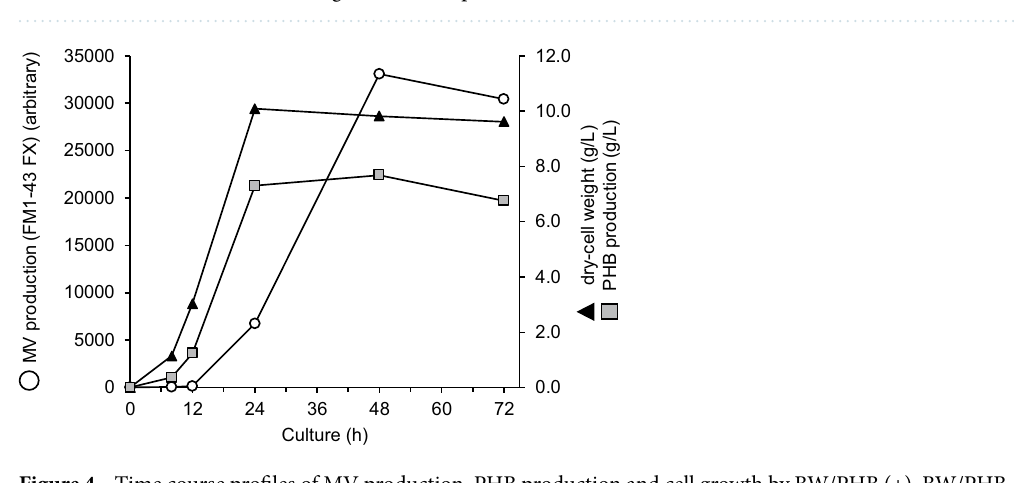
Figure 3. Microscopic and biochemical characterization of the MVs. ( A ) TEM images of MV fractions of BW/ PHB (+). Scale bar represents 100 nm. ( B ) The particle size distribution was analyzed by NanoSight tracking analysis. ( C ) Protein profiles of MV preparations from BW/PHB (+), BW/PHB (−) and BW. Purified MV samples were analyzed by SDS-PAGE using 12.0% acrylamide gel and stained with CBB. Estimated proteins of the main bands are shown on the right. Lane M represents the marker.